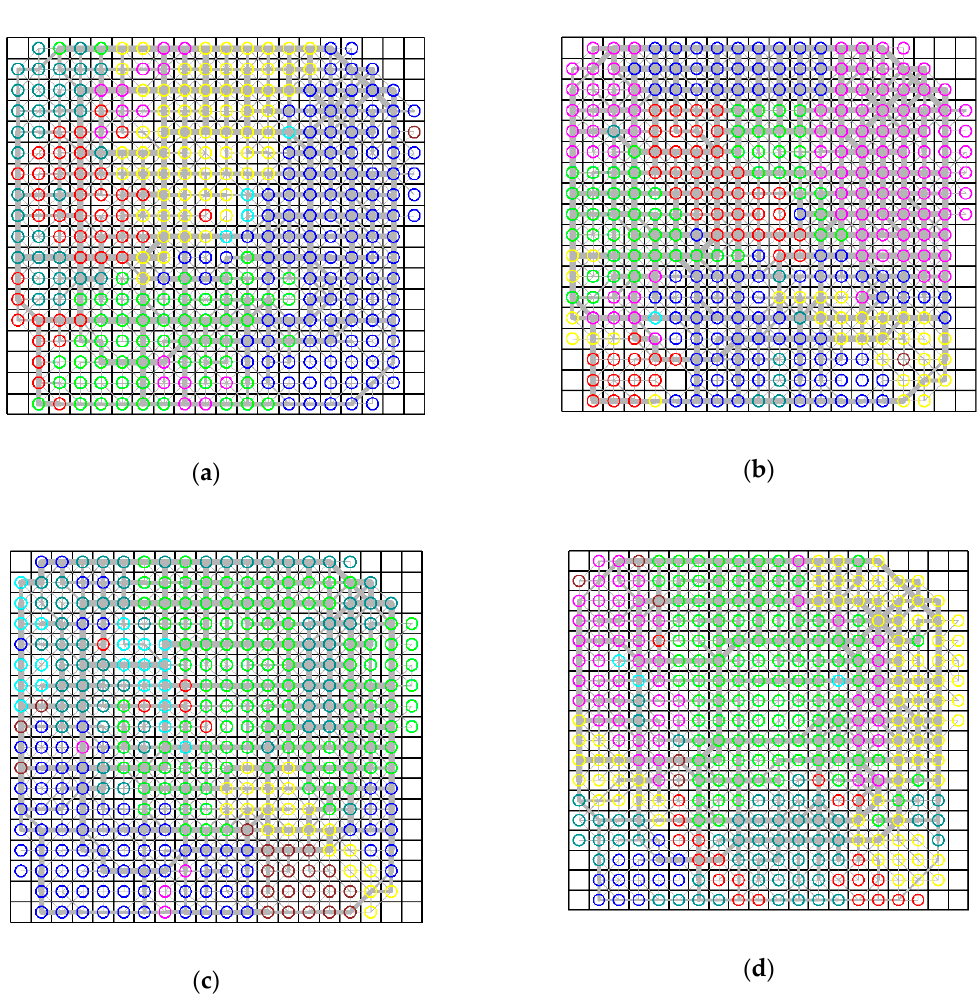
Figure 7. Communities in different time periods with cell size k = 1000 m: ( a ) morning rush hour; ( b ) noon rush hour; ( c ) evening rush hour; ( d ) midnight.